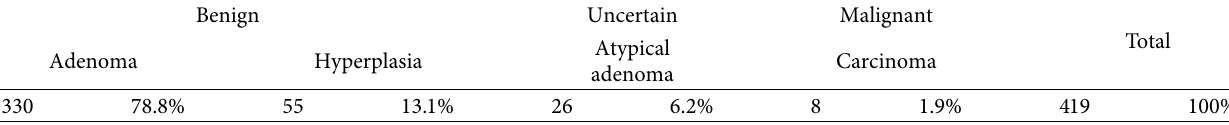
Table 1: Causes of PHPT in our